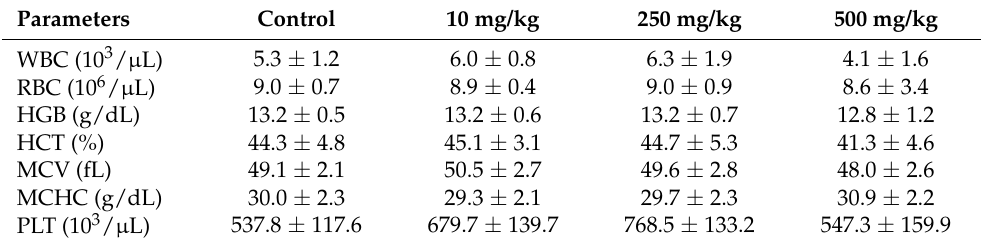
Table 5. Comparison of PsA versus vehicle control-treated hematological parameters white blood cell count (WBC), red blood cell count (RBC), hemoglobin count (HGB), hematocrit (HCT), mean corpuscular volume (MCV), mean corpuscular hemoglobin concentration (MCHC), and platelet count (PLT) in male Swiss albino mice. Data shown as mean ± SEM for n = 5/sex/group.